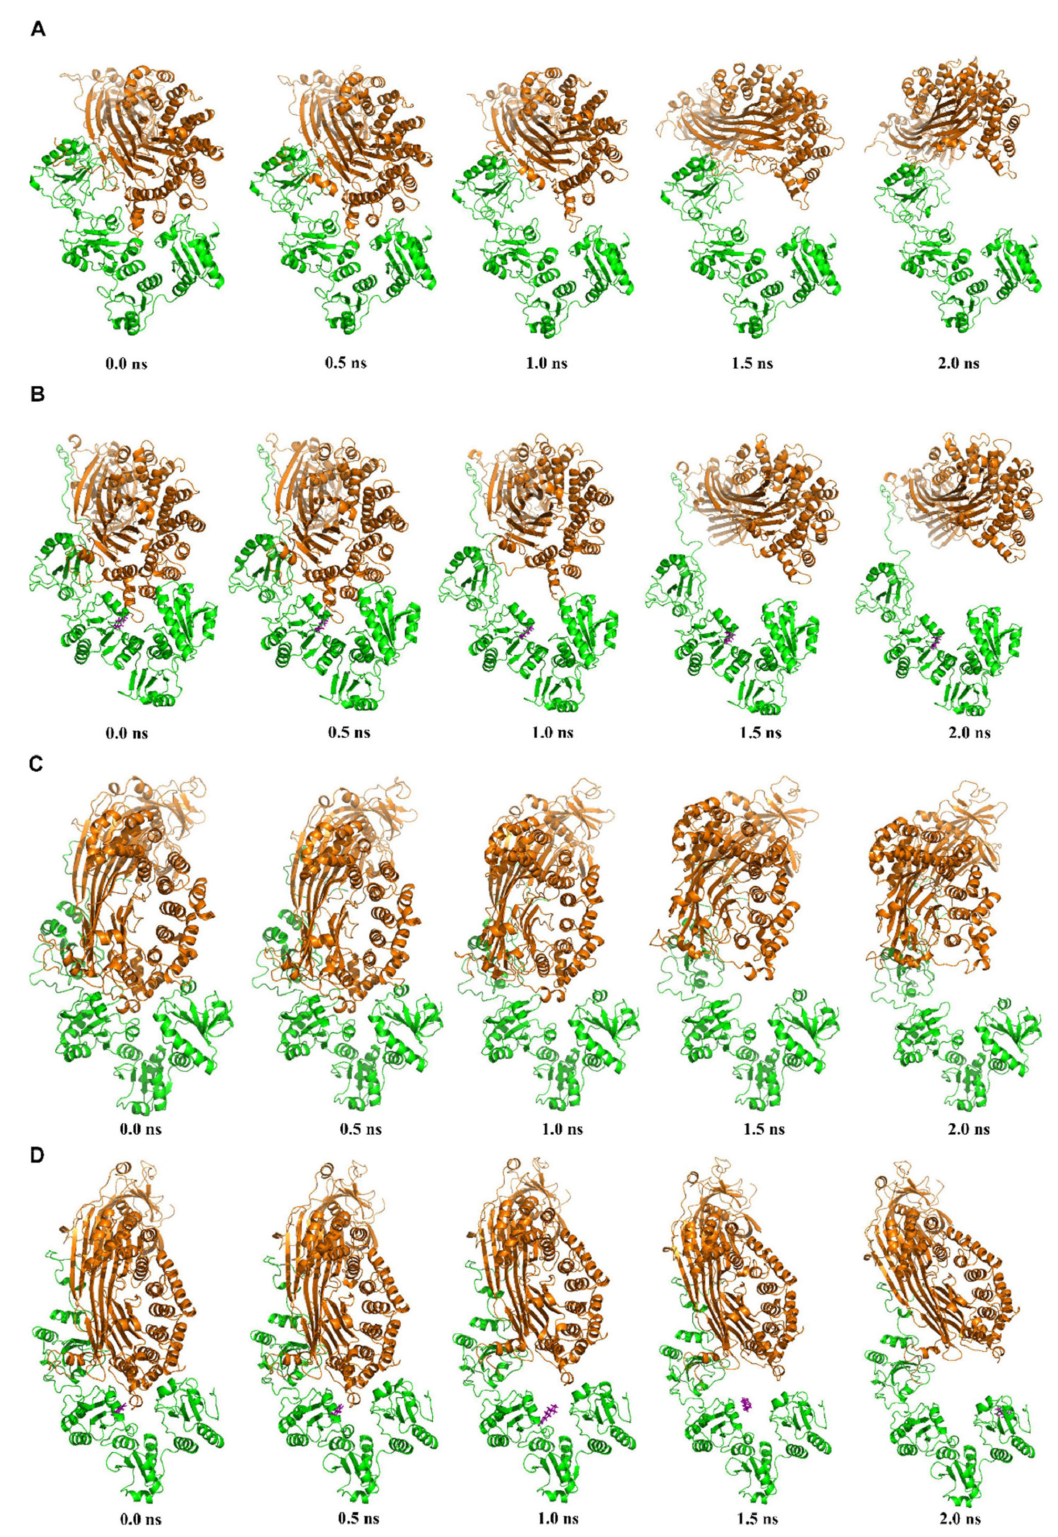
Figure 5. Representative conformations of hMTP and hMTP–E 2 complexes during the steered molecular dynamics (SMD) simulation process. For convenience of description, SMD simulations using the conformations after MDs with and without a hydrogen bond constraint are named as the first and second SMDs, respectively. ( A ) Representative snapshots of hMTP complex during the first SMDs. ( B ) Representative snapshots of hMTP–E 2 complex during the first SMDs. ( C ) Representative snapshots of hMTP complex during the second SMDs. ( D ) Representative snapshots of hMTP–E 2 complex during the second SMDs. The hMTP α subunit, hPDI and E 2 are colored in orange, green and purple,